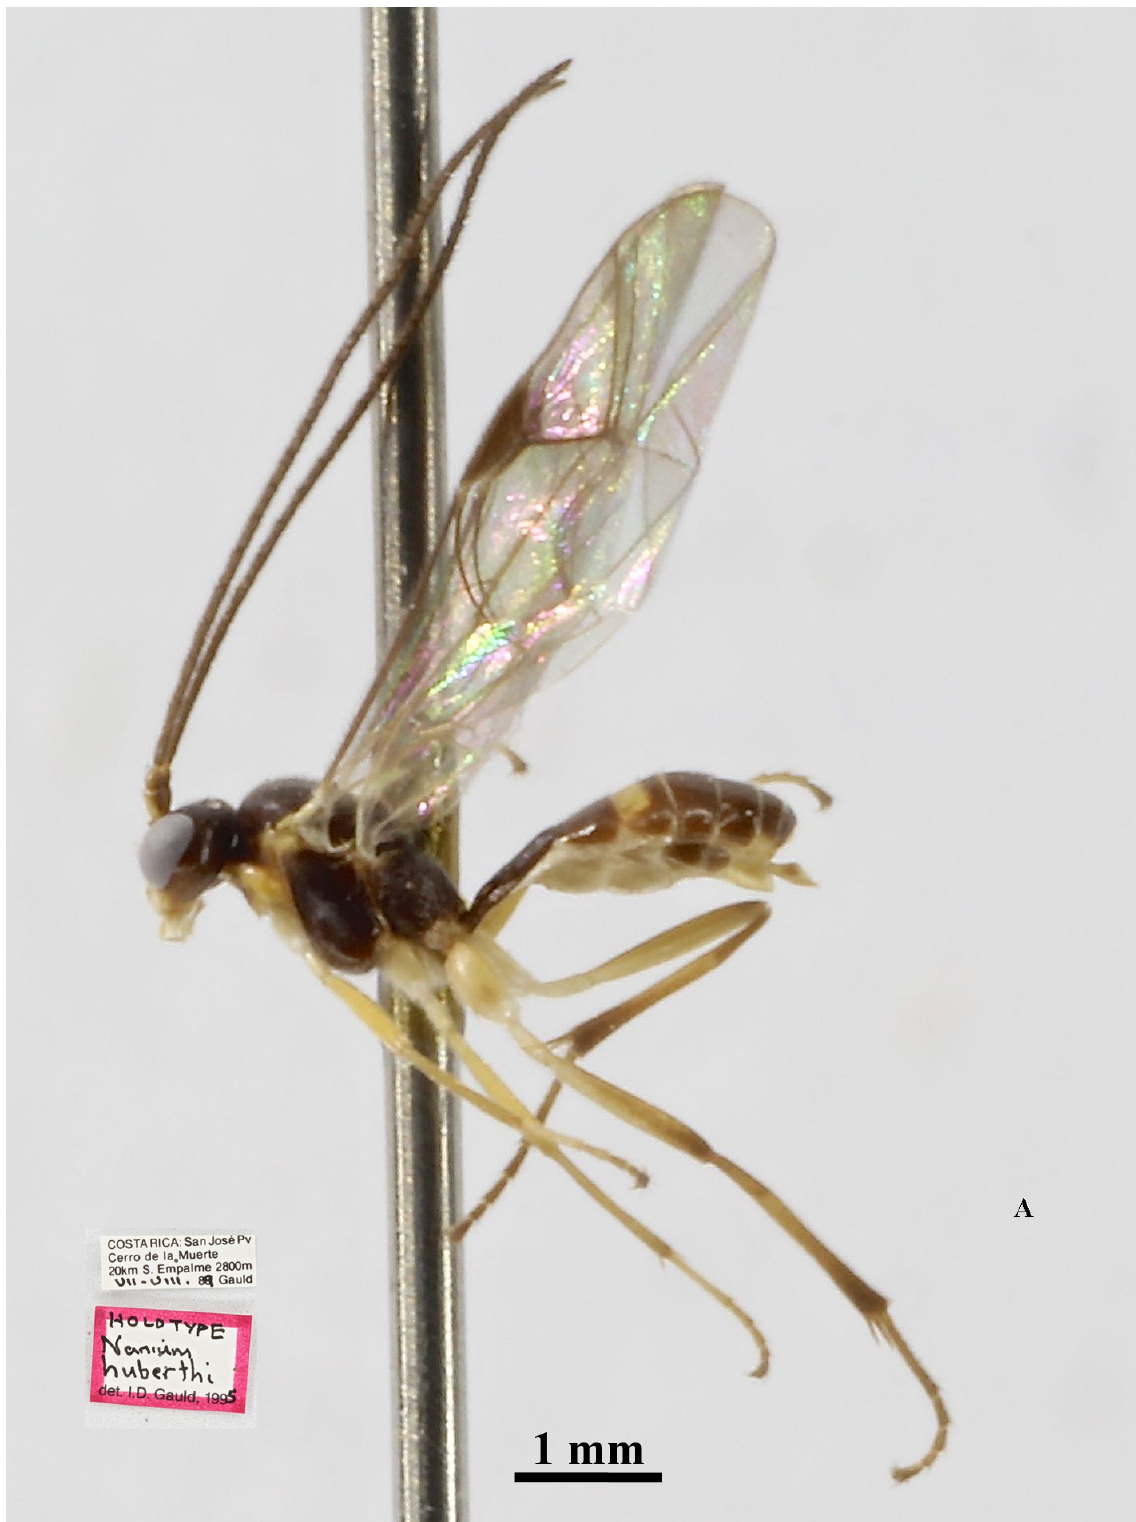
Fig. 4 . Nanium huberthi Gauld, 1997, holotype, ♀, habitus